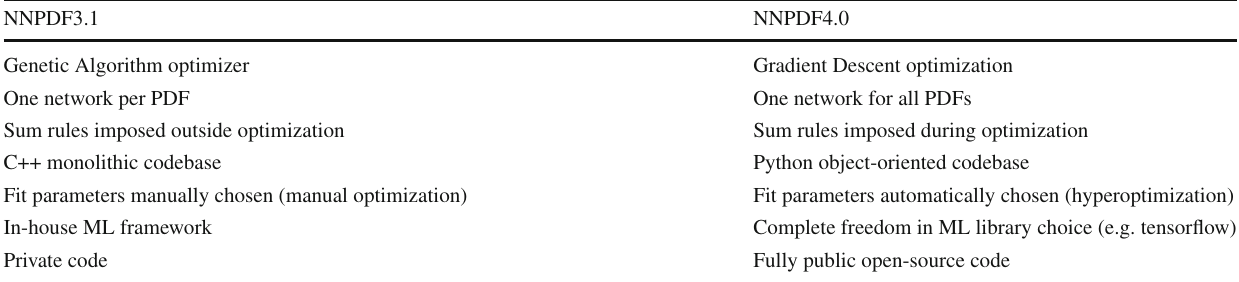
Table 7 Summary of the main differences between the NNPDF3.1 and the NNPDF4.0 code